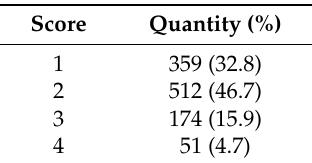
Table 4. The quantity of the zones having each score